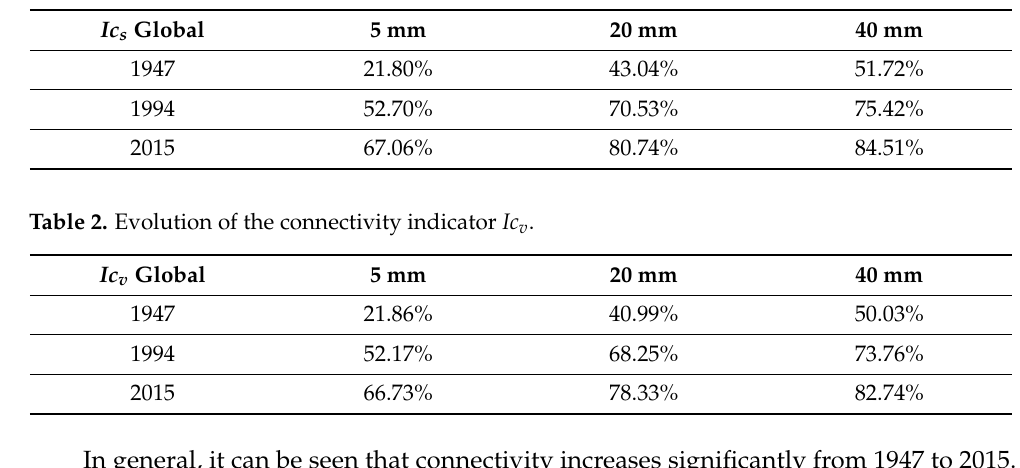
Table 1. Evolution of the connectivity indicator Ic s .